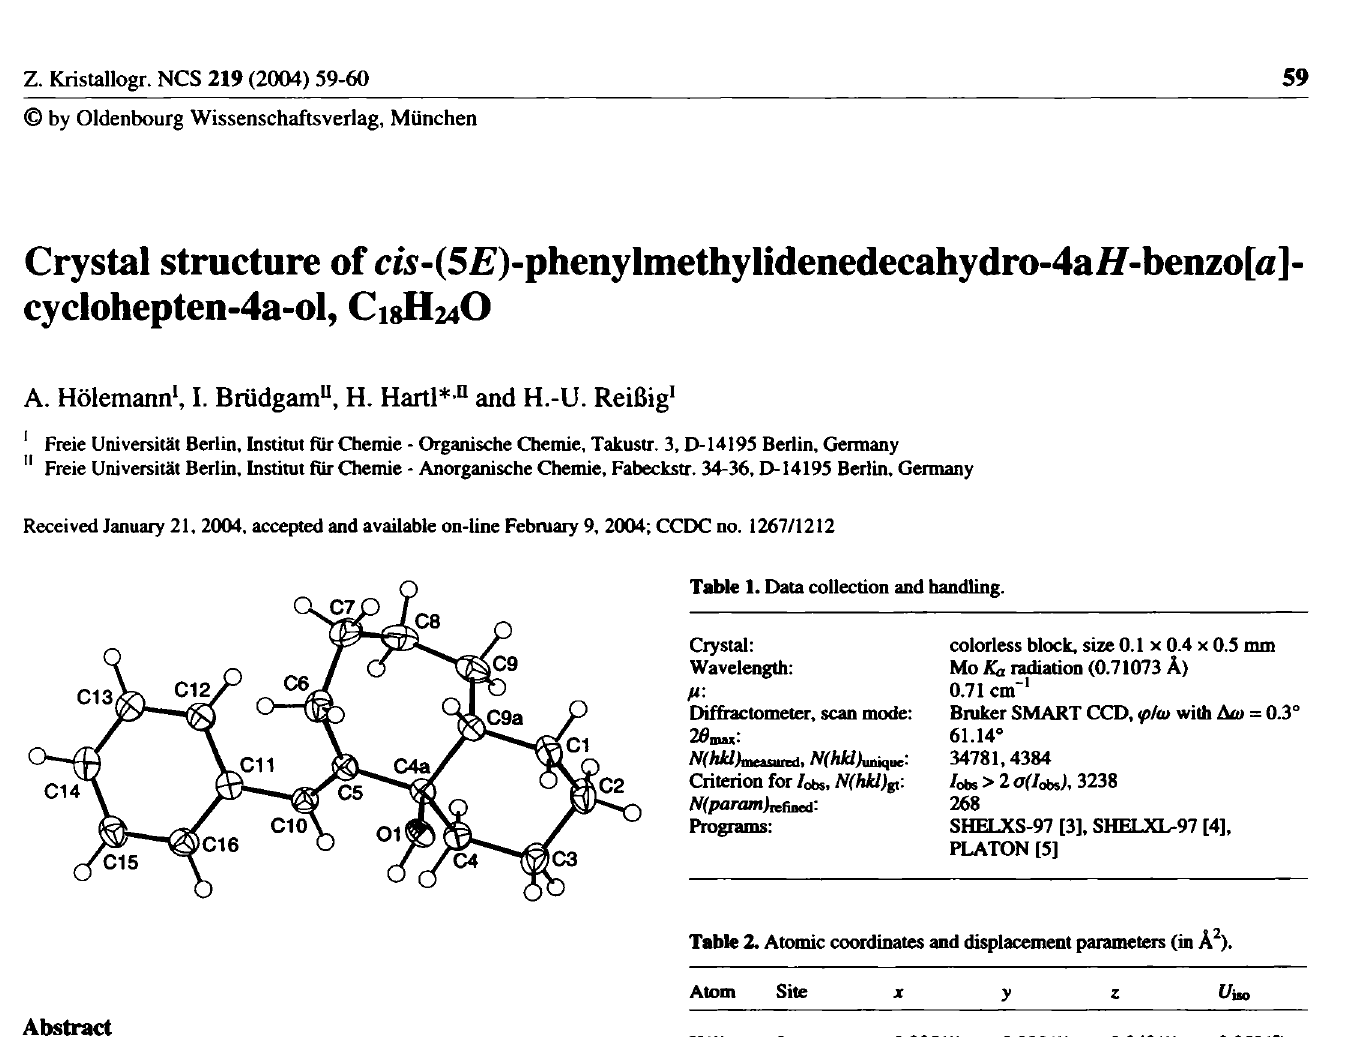
Table 2. Atomic coordinates and displacement parameters (in Ä 2